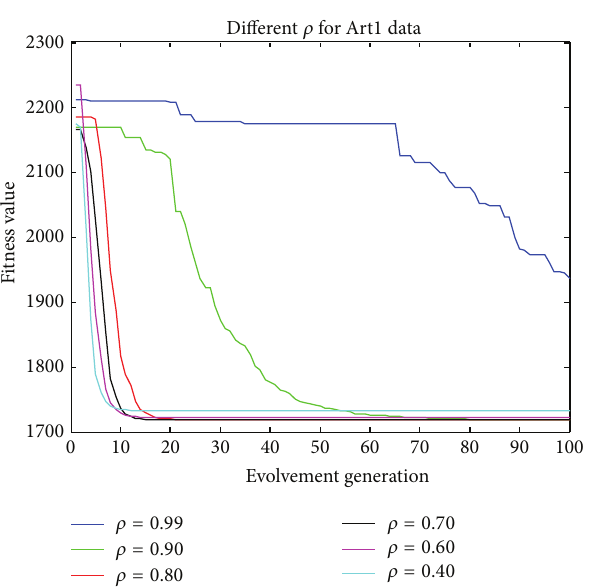
Figure 17: The convergence curve of the Art1 with different 𝜌 .